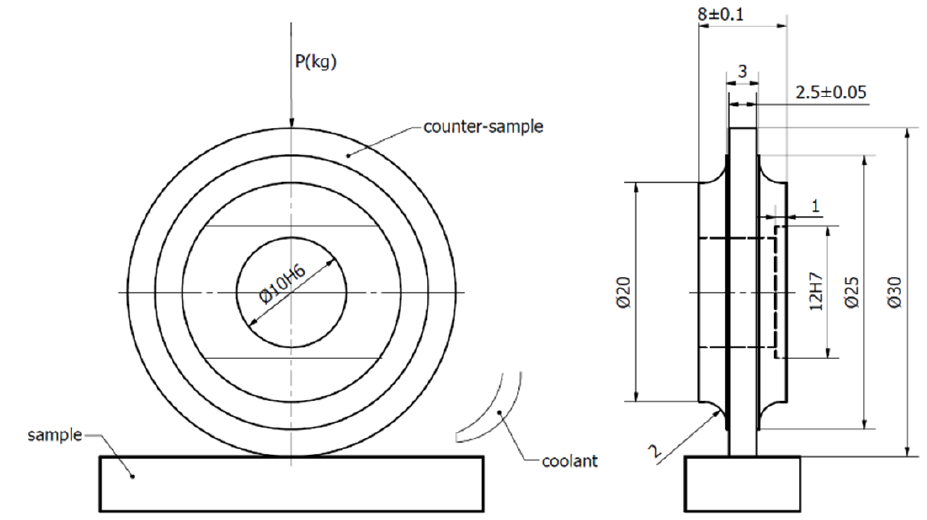
Figure 1. Stand for determination of wear at sliding friction.